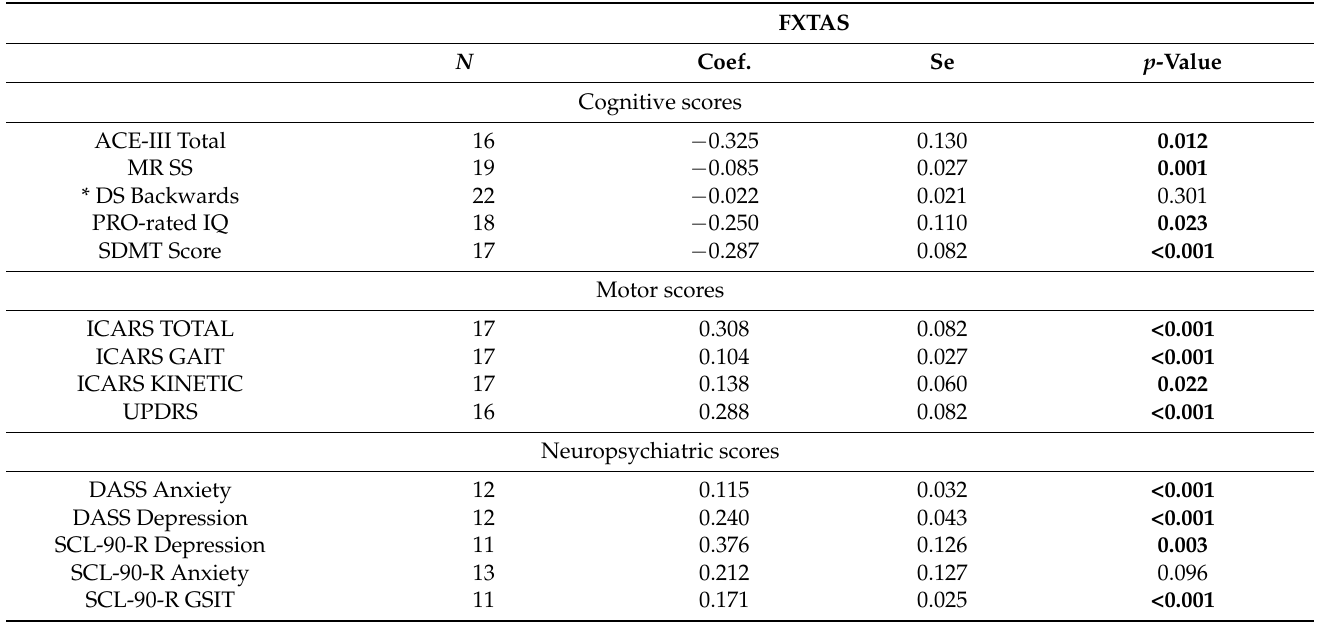
Table 2. Relationships between each cognitive, motor, and neuropsychiatric score with CGG repeats using robust regression. FXTAS N Coef. Se p -Value Cognitive scores